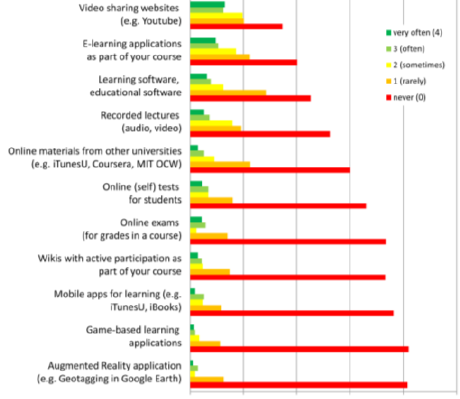
Figure 10: Valid percent of instructors’ responses to